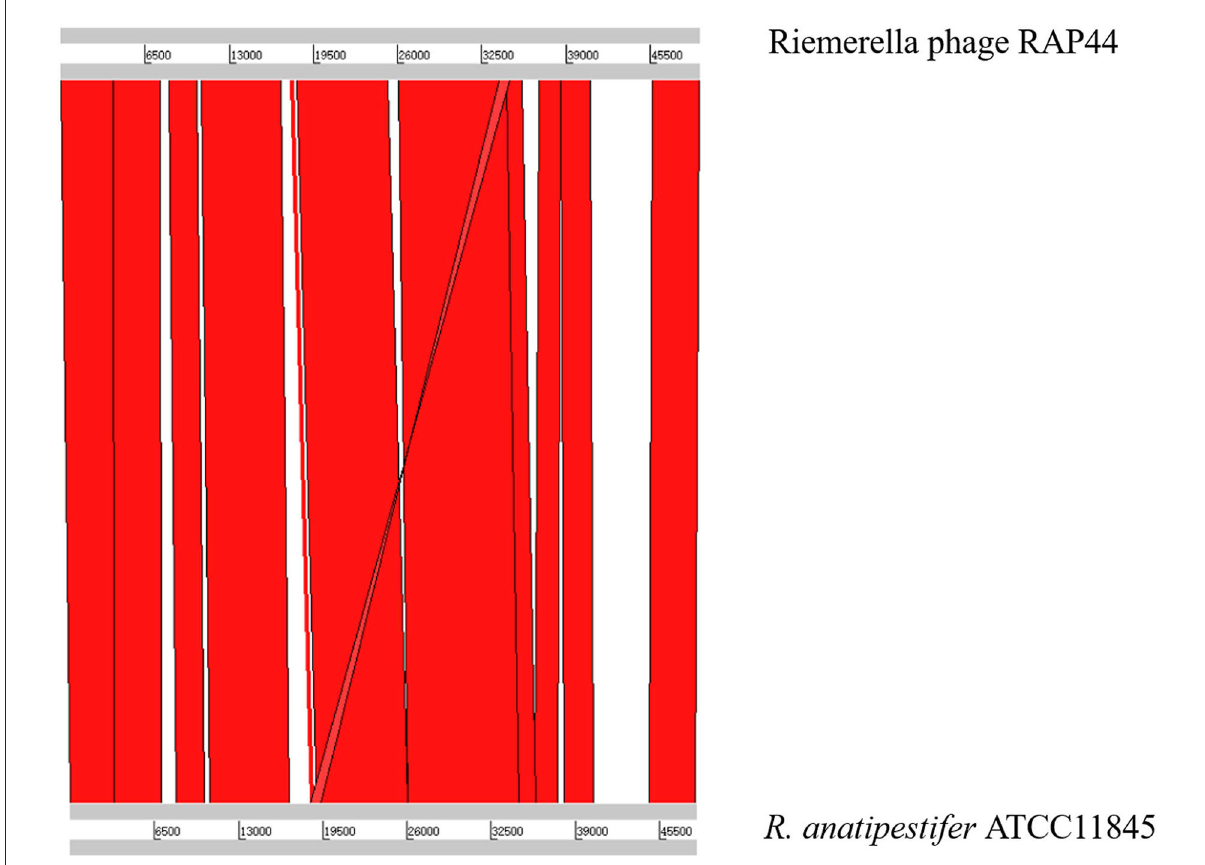
FIGURE2 The relationship between 50K genomic island and RAP44